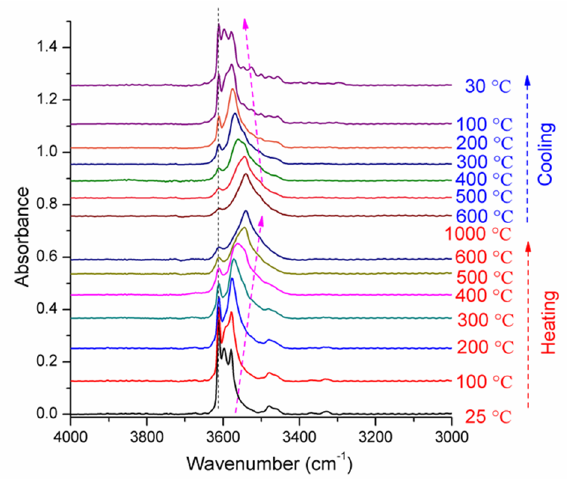
Figure 10. IR spectra change in shape and position of the OH absorptions with temperature (infrared light perpendicular to (100), electric vector E of the light wave is parallel to [010]).